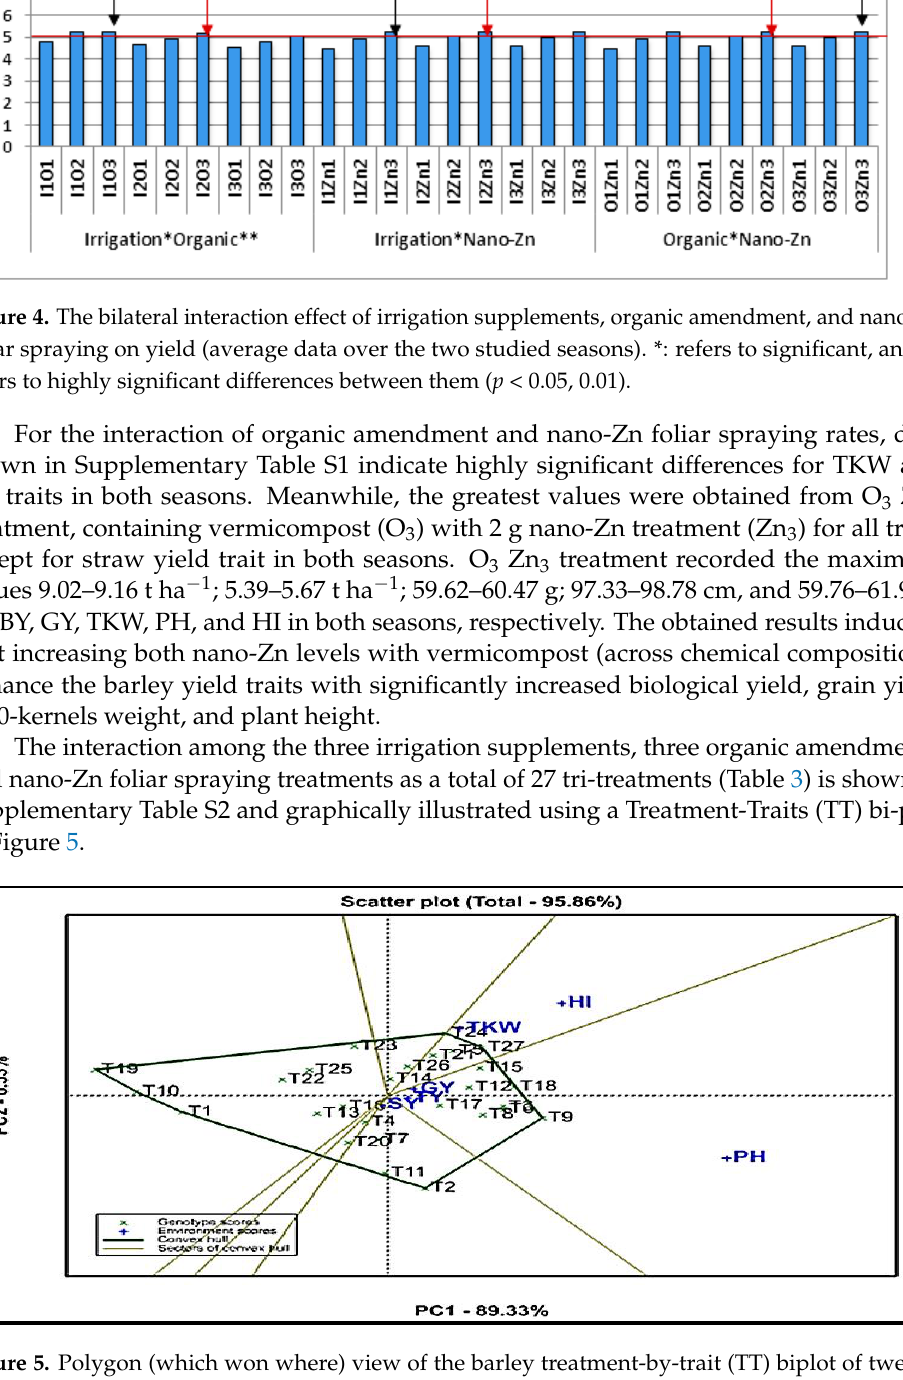
Figure 4. The bilateral interaction effect of irrigation supplements, organic amendment, and nano- Zn foliar spraying on yield (average data over the two studied seasons). *: refers to significant, and **: refers to highly significant differences between them ( p < 0.05 , 0.01).